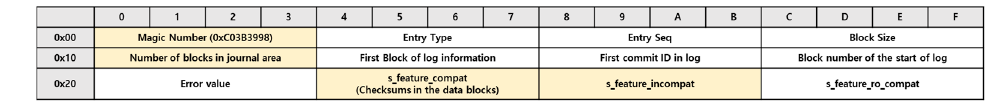
Figure 2. Journal superblock and journal block header of Ext4 file system.